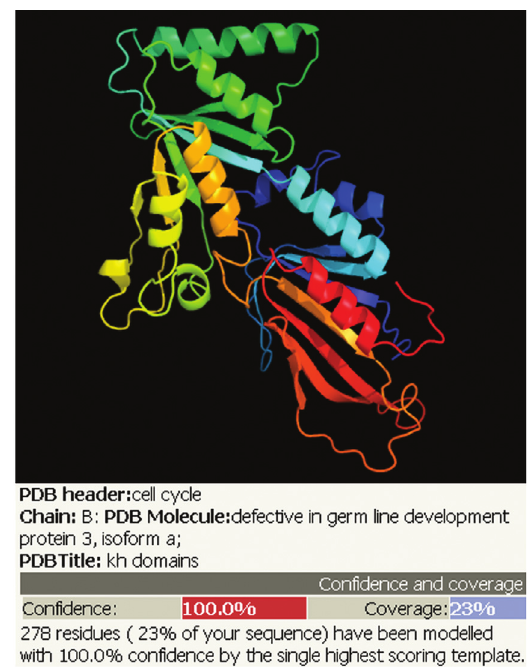
Figure 4 - Structural prediction of ScScp160 protein (Phyre2